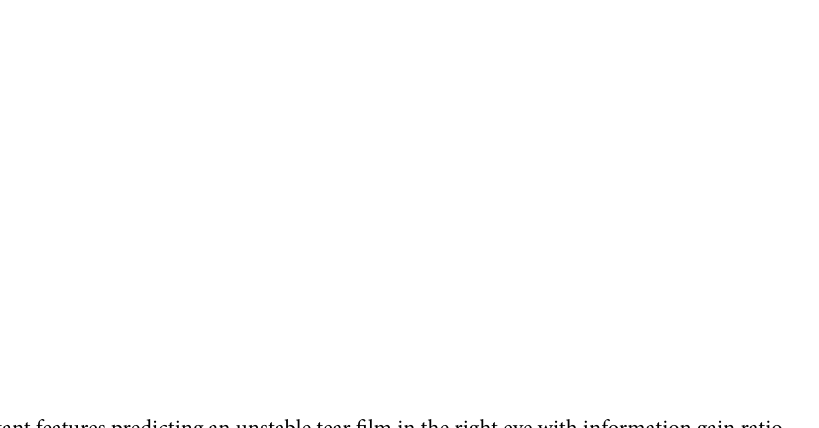
Table 5. Most important features predicting an unstable tear film in the right eye with information gain ratio. OD right eye, OS left eye, ST Schirmer test, ME meibomian gland expressibility, MQ meibum quality, OSDI ocular surface disease index, OSS ocular surface staining, Osm osmolarity.